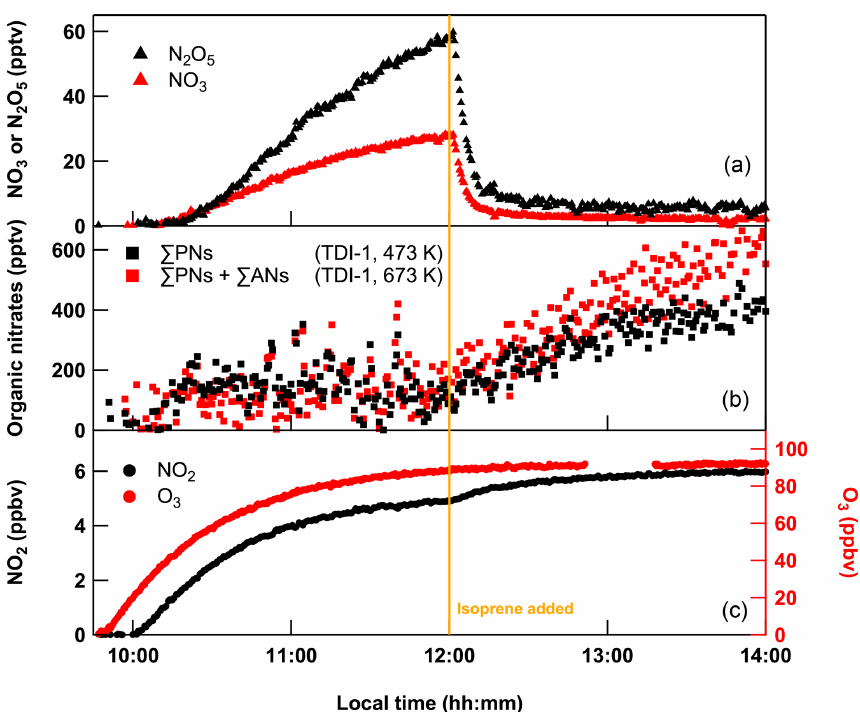
Figure 2. Evolution of the mixing ratios of NO 2 , (cid:54) PNs, (cid:54) PNs + (cid:54) ANs, N 2 O 5 and O 3 when flowing 150sccm NO 2 (from 1ppmv bottle), 7sccm isoprene (from a 46.5ppmv cylinder) and 24SLPM of zero air (of which 5SLPM was passed over a PenRay lamp) into SCHARK. Isoprene was added at 12:00LT after the system was close to steady state. Note that the NO 2 and N 2 O 5 mixing ratios were subtracted from the organic nitrate signals (b)